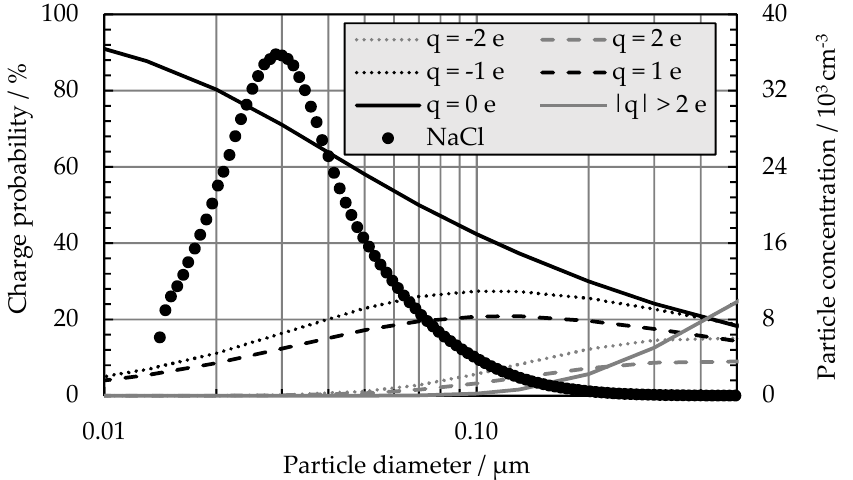
Figure 2. Charge probability of particles in bipolar charge equilibrium according to [34] and the raw gas particle size distribution measured with scanning mobility particle sizer (SMPS) (Model 3934, TSI GmbH).